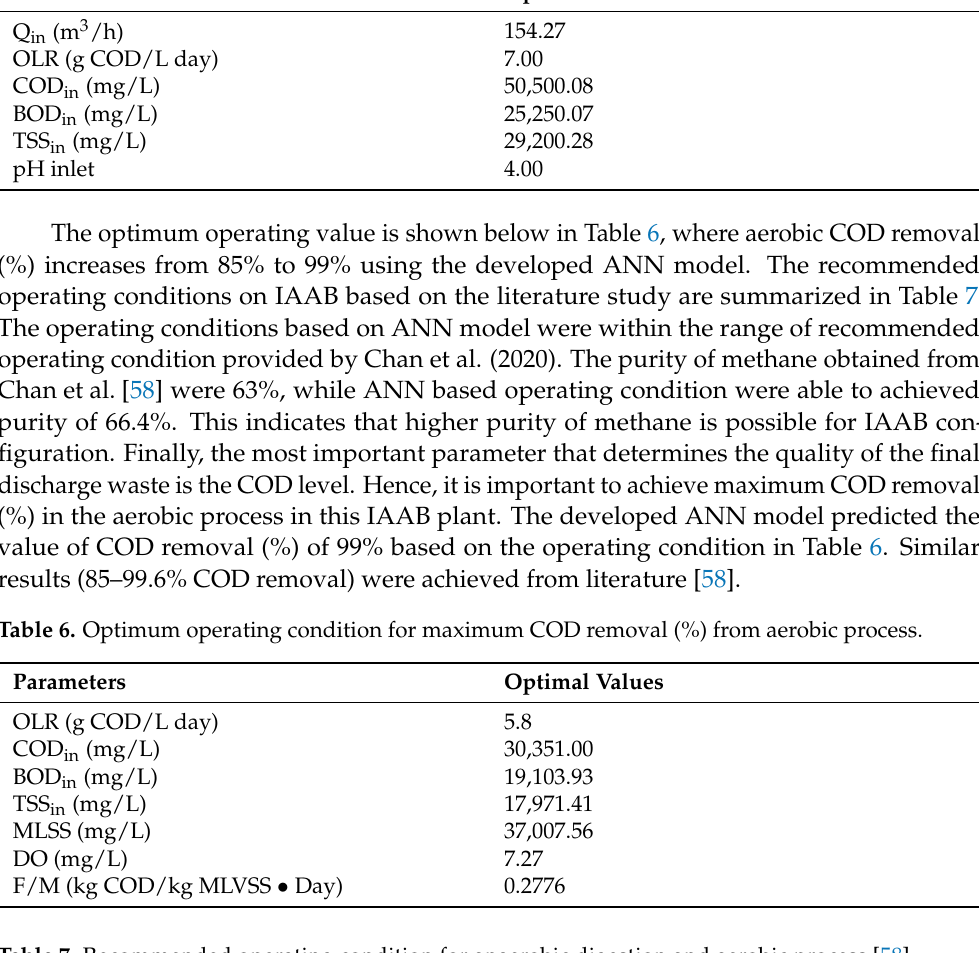
Table 7. Recommended operating condition for anaerobic digestion and aerobic process